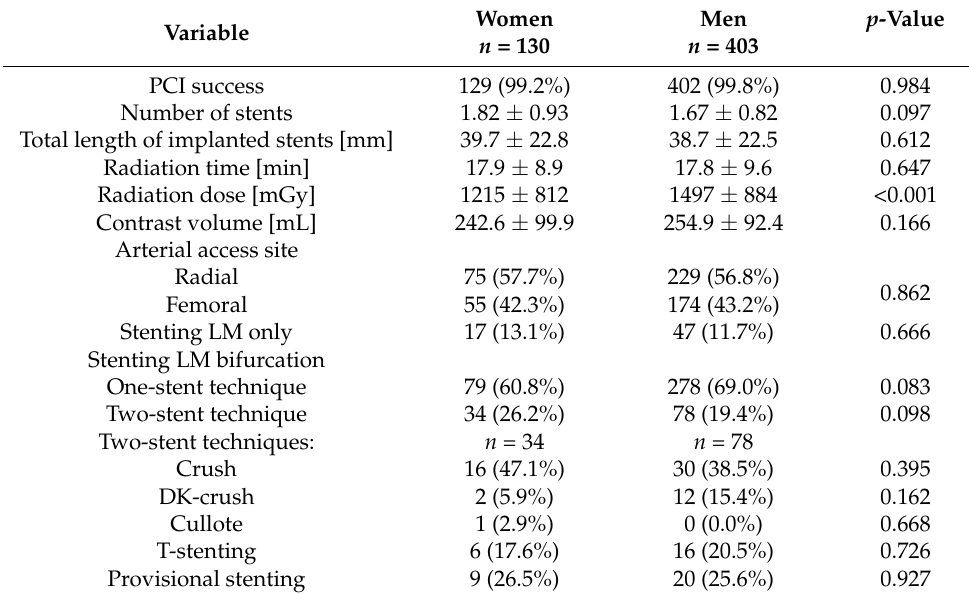
Table 3. Left main PCI procedure